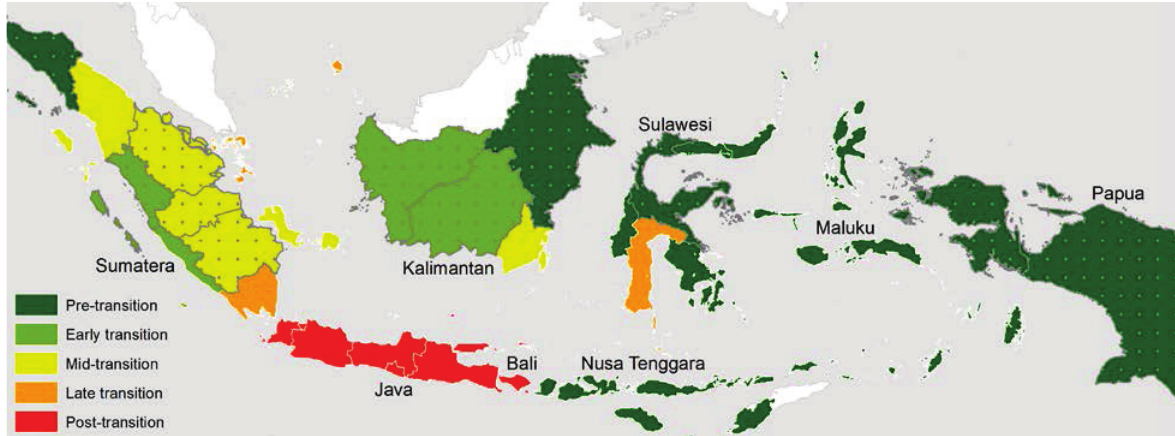
Figure 4 Forest transition trajectory across main Islands in Indonesia, and indicated REDD+ pilot province (with dots